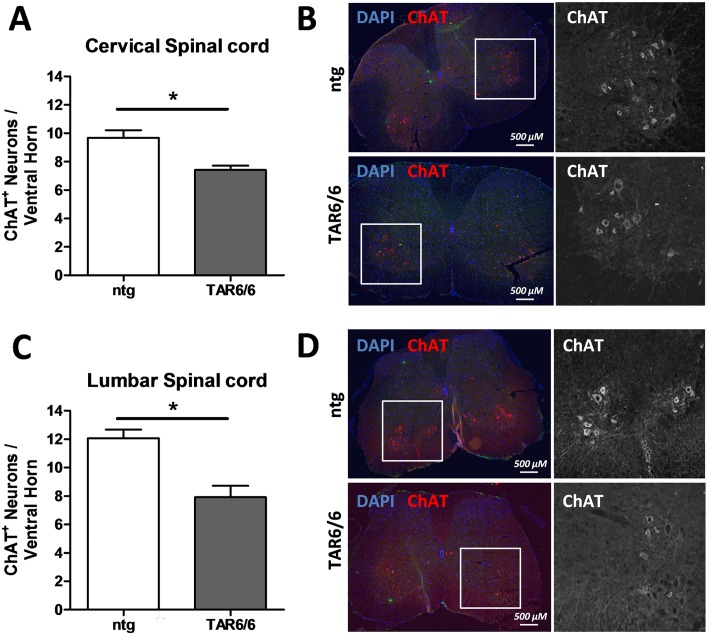
Quantification of neuron loss in the spinal cord of 3 months old TAR6/6 mice.(A, C) Number of ChAT+ neurons in the ventral horn of the cervical (A) and lumbar (C) spinal cord grey matter. (B, D) Representative images of ChAT labeling in the cervical (B) and lumbar (D) spinal cord of 3 months old TAR6/6 mice compared to ntg animals. Nuclei of cells were stained by DAPI. (A) ntg: n = 4, TAR6/6: n = 3. (C) ntg: n = 3, TAR6/6: n = 3. Unpaired Student’s t-test followed by Welch’s correction. Mean+SEM. *p<0.05.